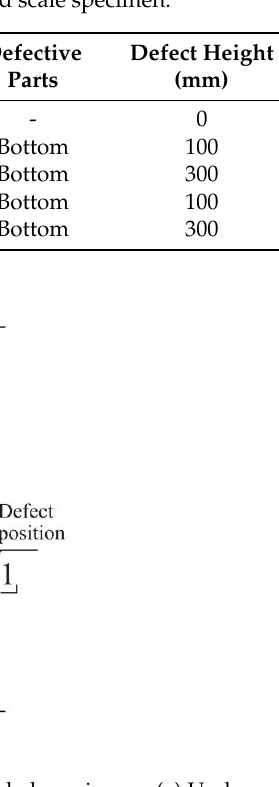
Table 1. Design parameters of reduced scale specimen.